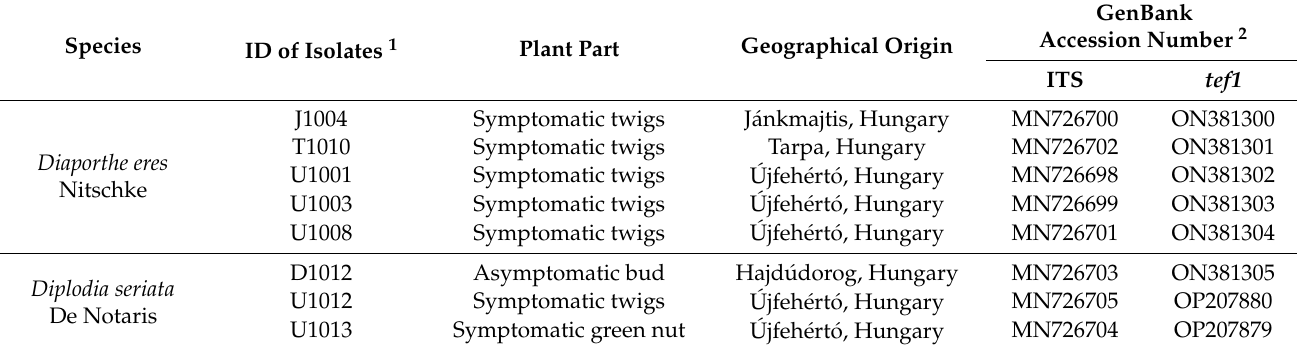
Table 2. Isolates cultured from walnut plant parts and accession numbers of the sequenced ITS and tef1 PCR